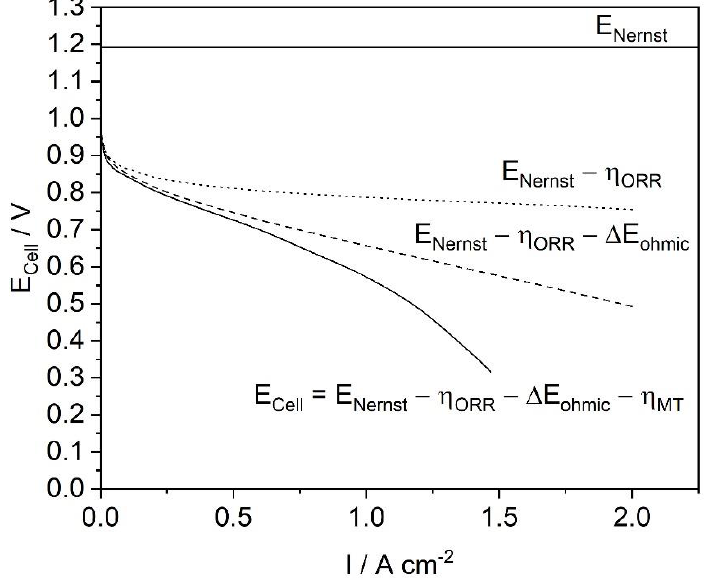
Figure 1. Example polarisation curves demonstrating the major losses which contribute to the deviation of the measured cell potential in comparison to the theoretical maximum Nernst equation.